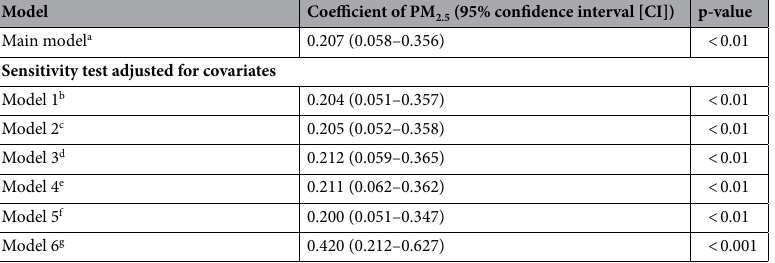
Table 3. Association models for LRI and PM 2.5 , controlled for various covariates. a Control variables included density of population, sex (% of male), age, smoking, alcohol consumption, economic status, healthcare expenditure, temperature, and wind speed. b Adjusted for density of population, sex (% of male), and age. c Adjusted for density of population, sex (% of male), age, and alcohol consumption. d Adjusted for density of population, sex (% of male), age, alcohol consumption, and smoking. e Adjusted for density of population, sex (% of male), age, alcohol consumption, smoking, and economic status. f Adjusted for density of population, sex (% of male), age, alcohol consumption, smoking, economic status, and healthcare expenditure. g Considered all covariates and eliminated data from Eastern Mediterranean